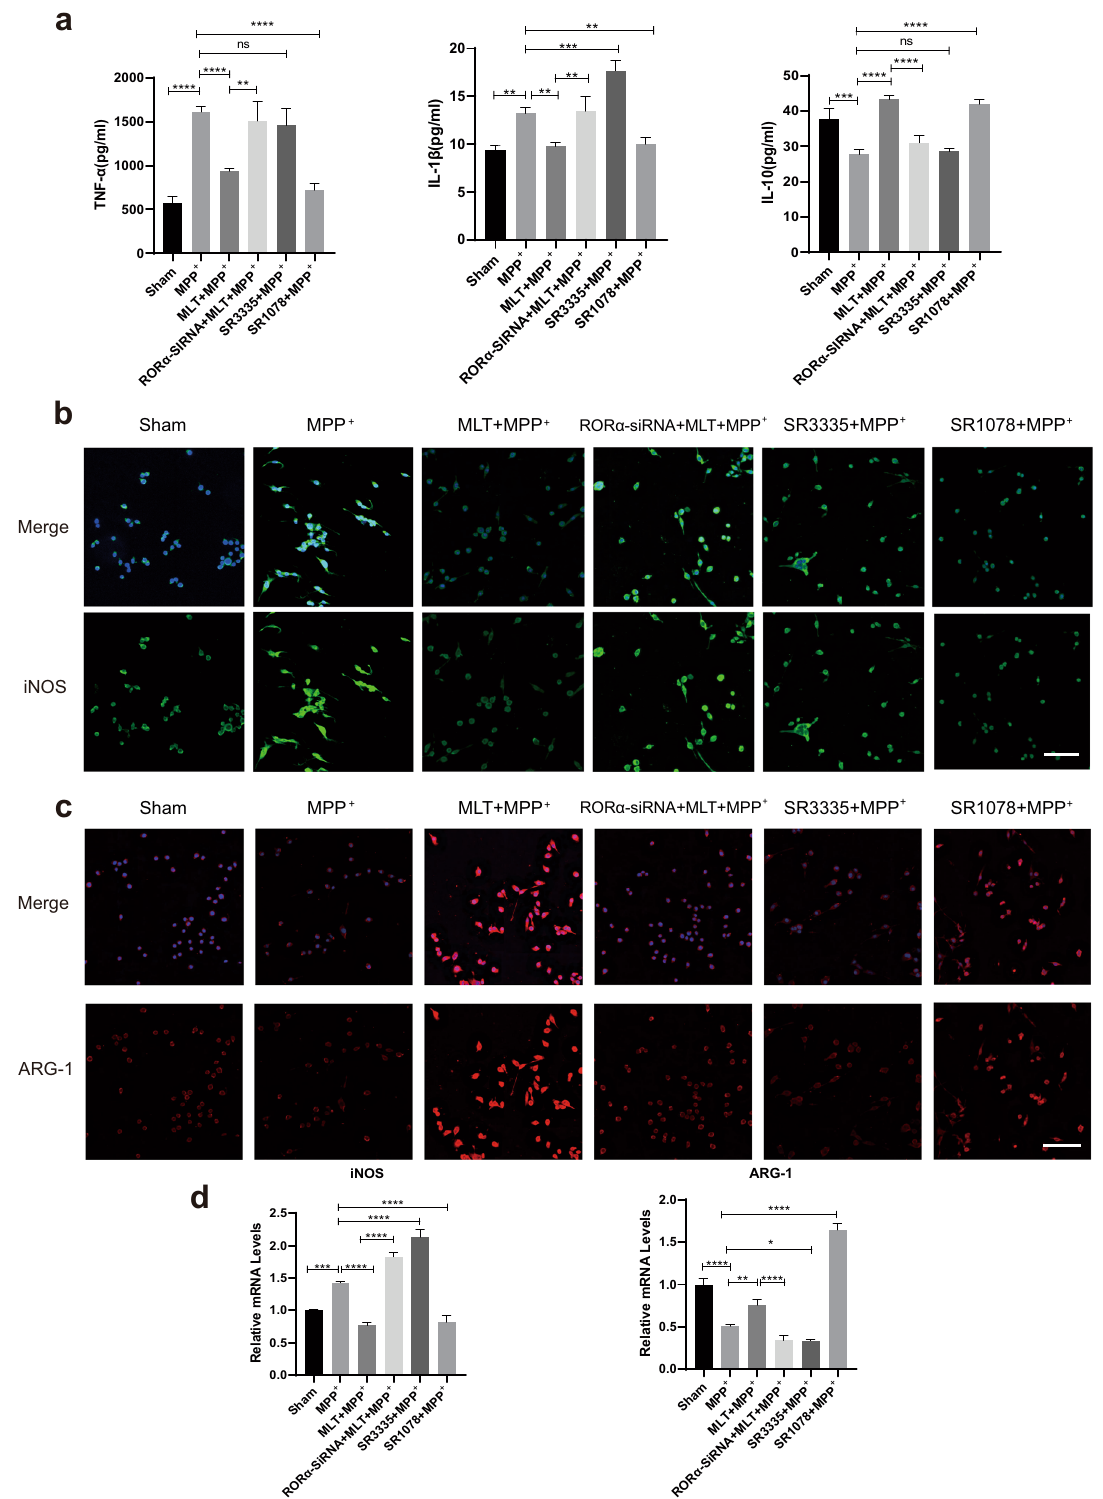
Fig. 5 The de fi ciency of ROR α promoted in fl ammation. BV2 cells were fi rstly transfected with siRNA for 48 h to knock down ROR α expression. MPP + (50 μ M), MLT (50 μ M), SR3335 (a synthetic selective inverse agonist of ROR α , 10 μ M), SR1078 (a synthetic agonist of ROR α , 10 μ M) were applied alone or combined (MLT, SR3335 and SR1078 were treated half an hour before MPP + ) for 24 h. a ELISA results indicated cell culture medium levels of TNF ‐ α , IL ‐ 1 β and IL ‐ 10. b , c Immuno fl uorescent staining images of iNOS (green) and ARG-1 (red). Blue indicates nuclei. Scale bars = 50 μ m. d RT-qPCR results showed the quantitative analysis of polarization markers iNOS and ARG-1 expressions in different cell groups. Data were average with error bars representing standard deviation. ( n = 3 independent experiments.* P < 0.05; ** P < .01; *** P < 0.001; **** P <